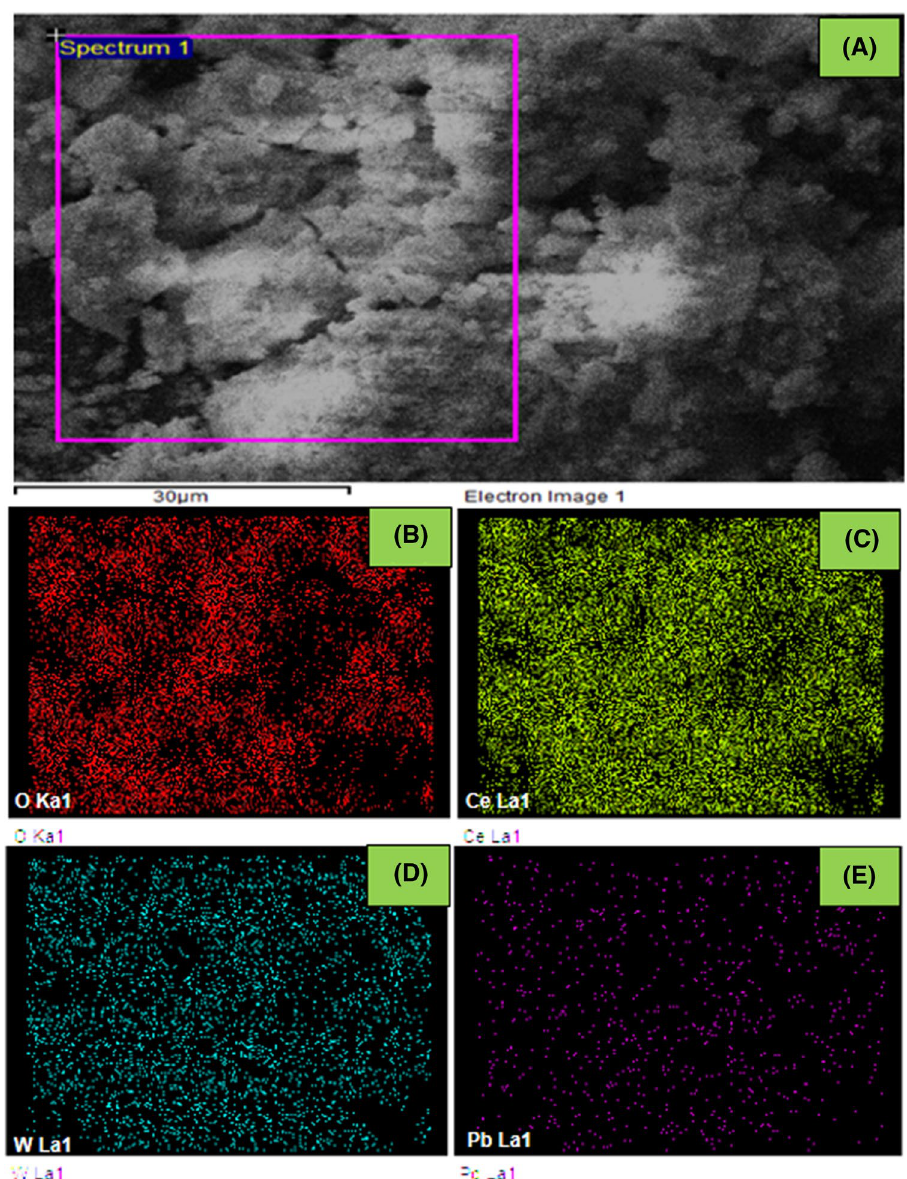
analysis of CeO 2 /PbWO 4 nano-